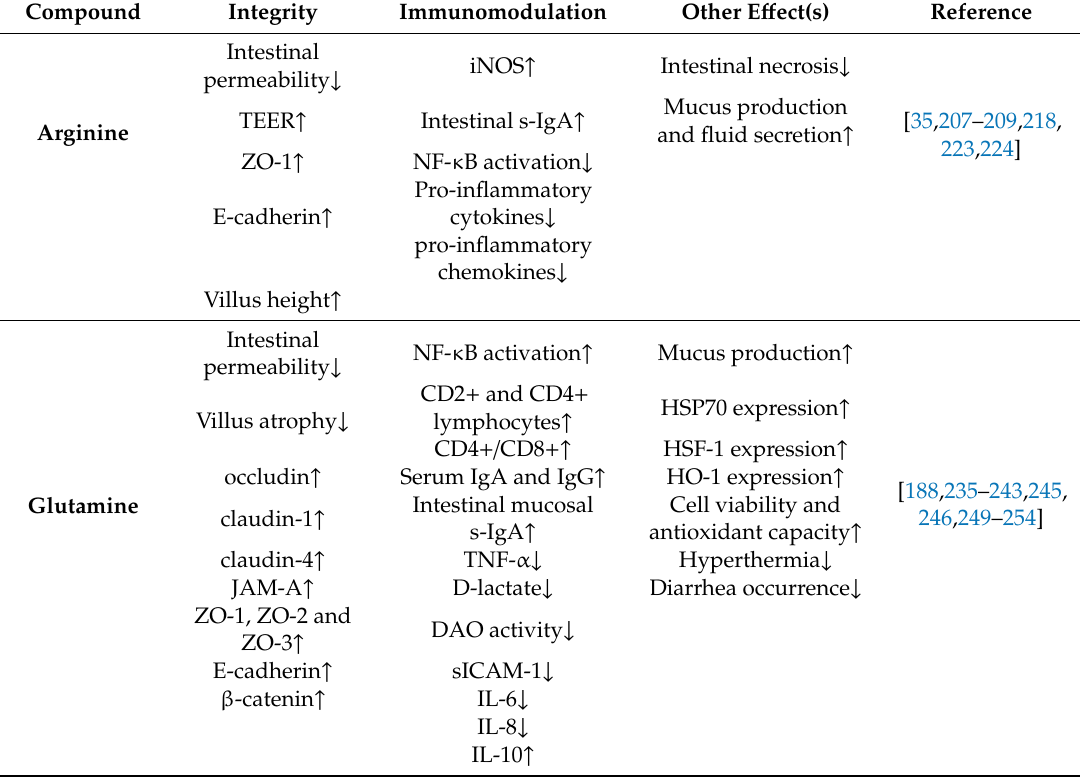
Table 4. The e ff ects of arginine and glutamine on intestinal integrity and